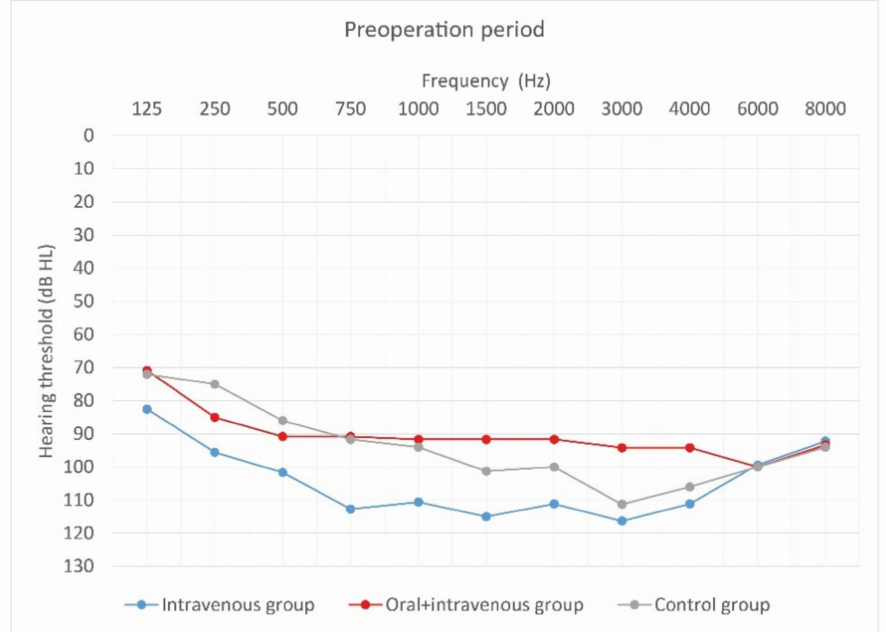
Figure 4. Mean hearing thresholds of patients with standard steroid therapy (i.v. group), patients with prolonged steroid therapy (oral + i.v. group) and control patients in the pre-operative period.